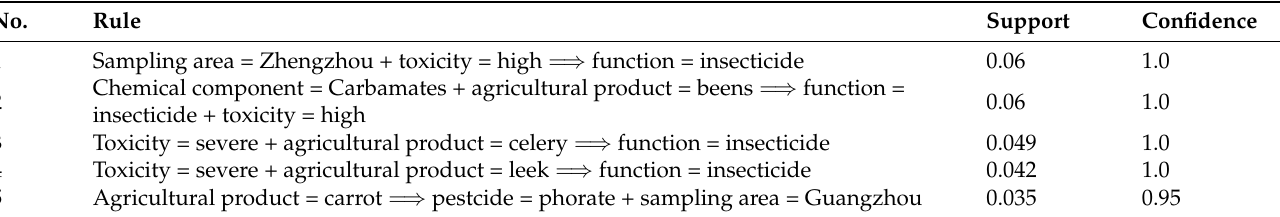
Table 6. First 5 interesting strong association